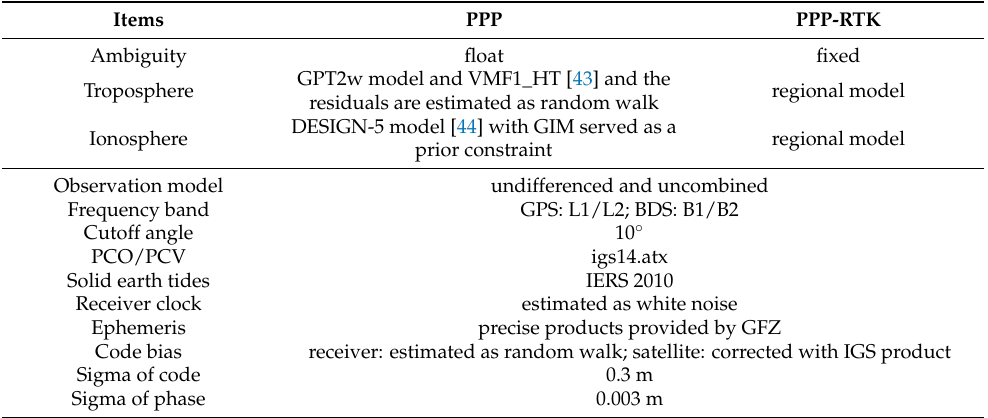
Table 2. GNSS data processing strategy of PPP and PPP-RTK.